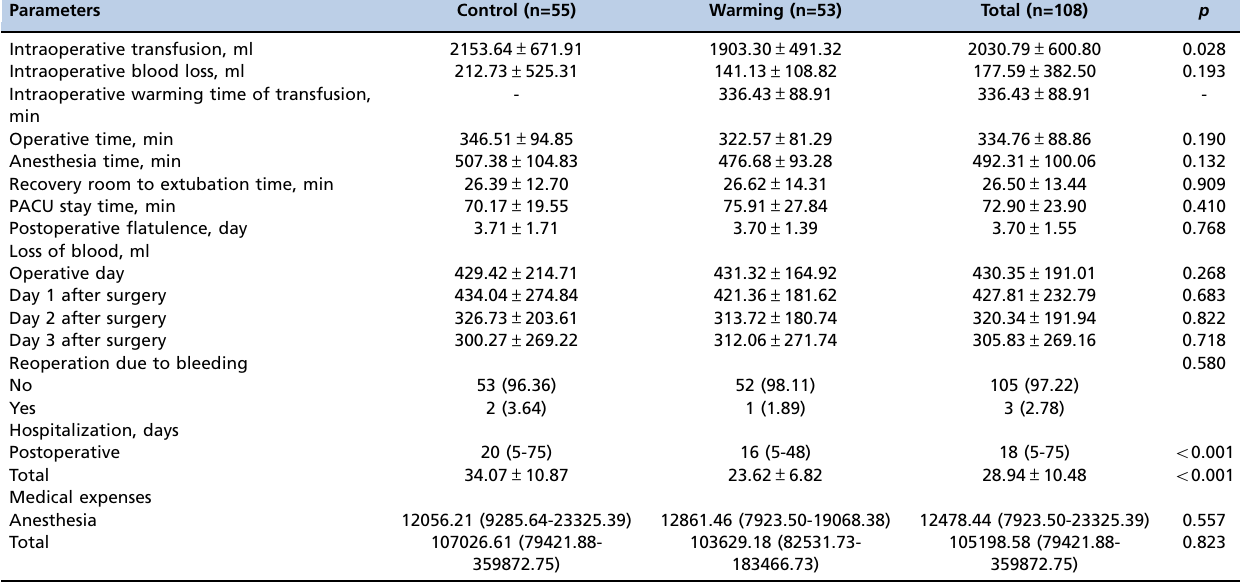
Table 2 - Patient ’ s operative information.